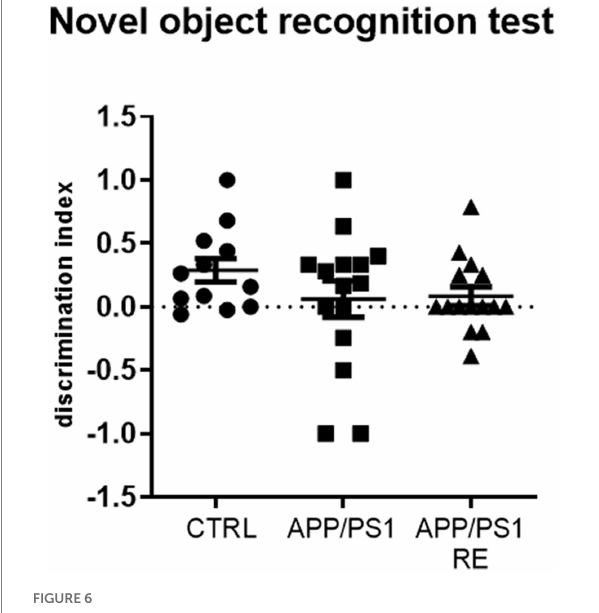
FIGURE 6 Seven-month-old APP/PS1 mice showed no impairment in short- term recognition memory. Values (mean ± standard error of the mean) represent the discrimination index for the novel object recognition test which was calculated by the ratio of the time spent on the new object minus the time spent in the familiar object to the total time spent on both objects. One-way ANOVA, n = 12–15